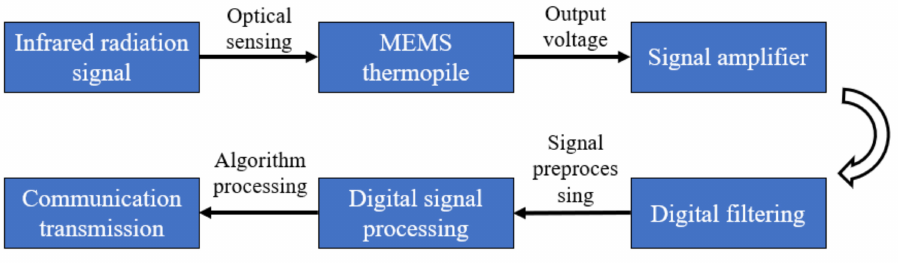
Figure 10. Signal flow chart.